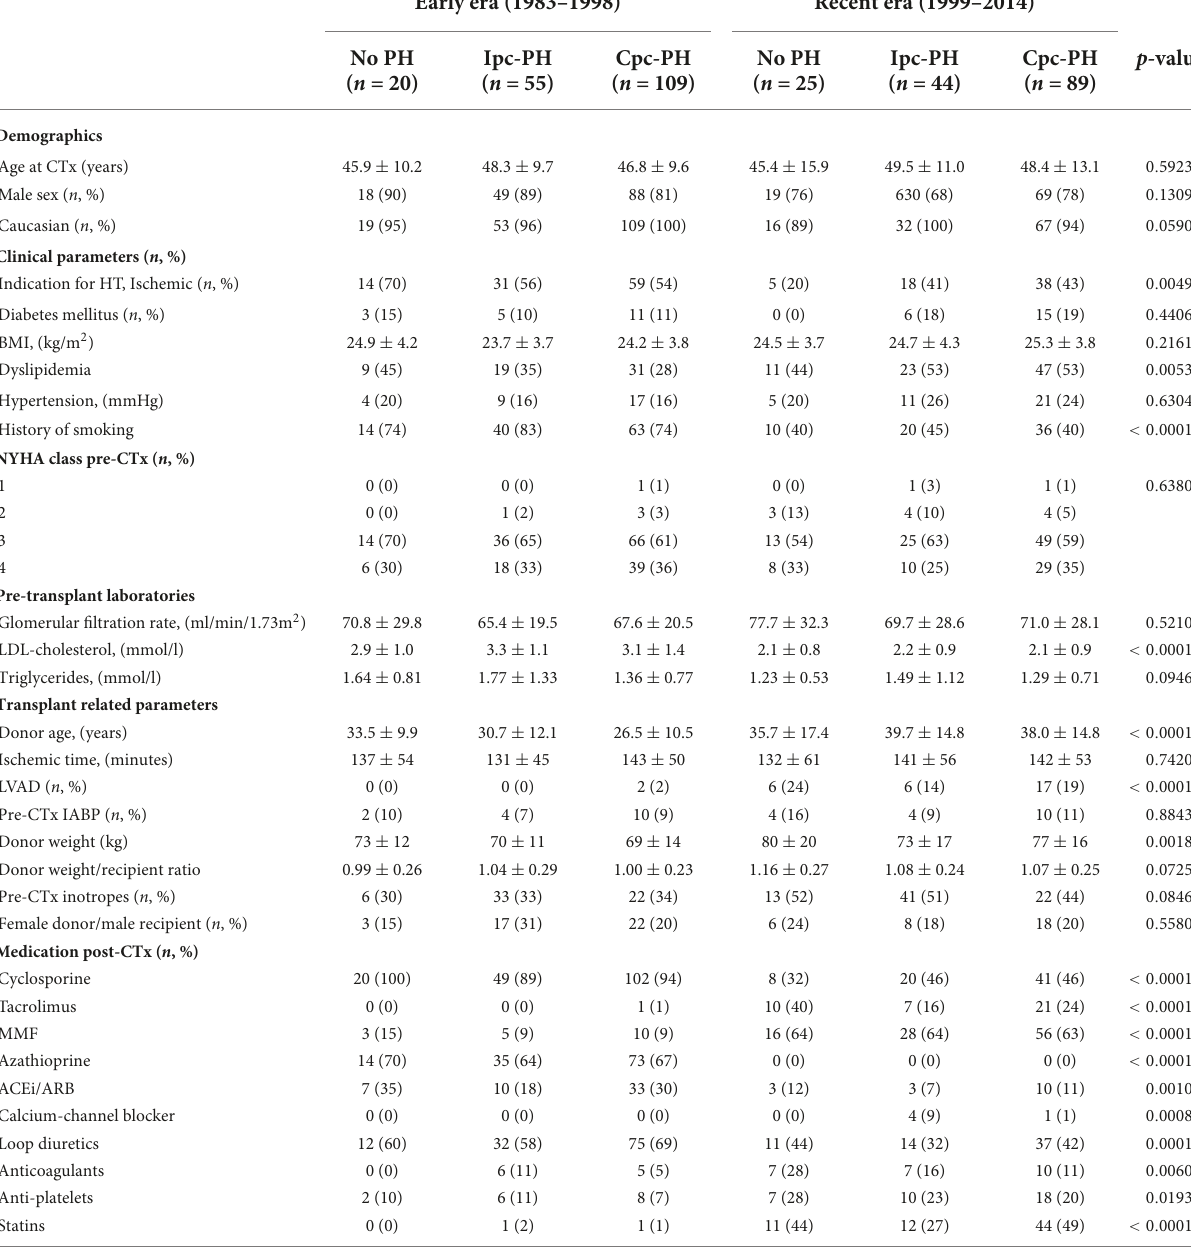
TABLE 1 Clinical characteristics of the study